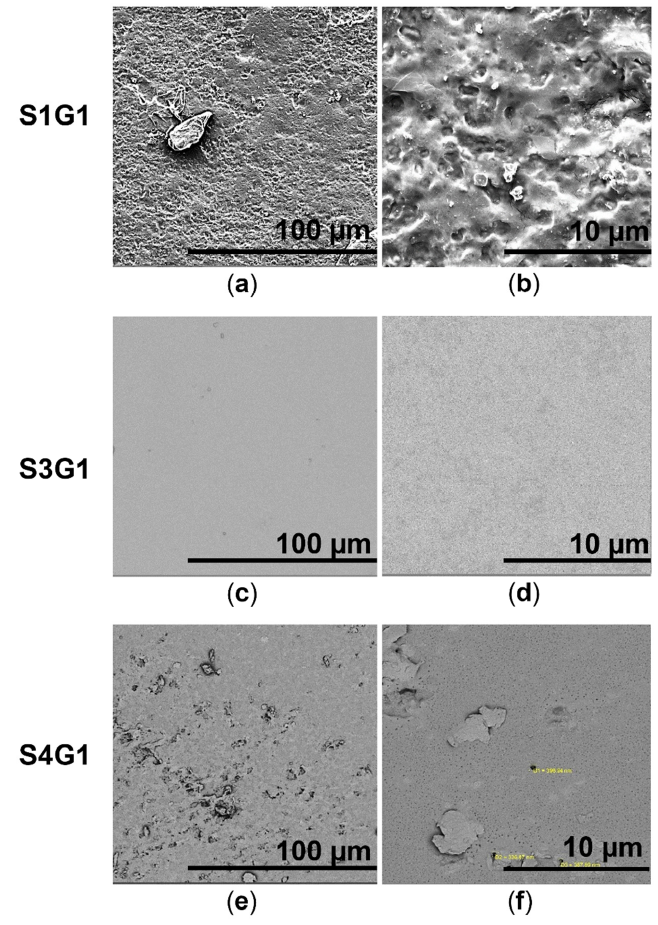
Figure 4. SEM images of hydrogels containing a constant amount of glycerin, such as 3.4% ( v/v ); ( a , b ) sample S1G1; ( c , d ) sample S3G1; ( e , f ) sample S4G1.